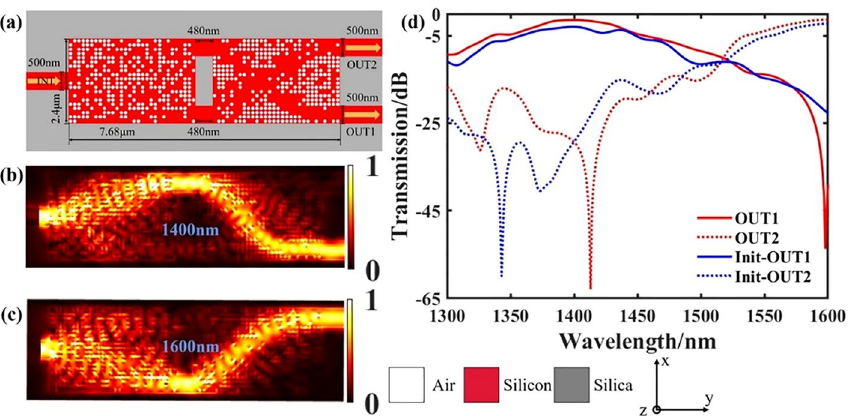
Figure 6. Design and simulation results of the optimized final structure. ( a ) The final structure after optimization. ( b , c ) are the simulated optical field distributions. ( d ) Comparison of transmission of each port of the optimized structure with the initial structure.